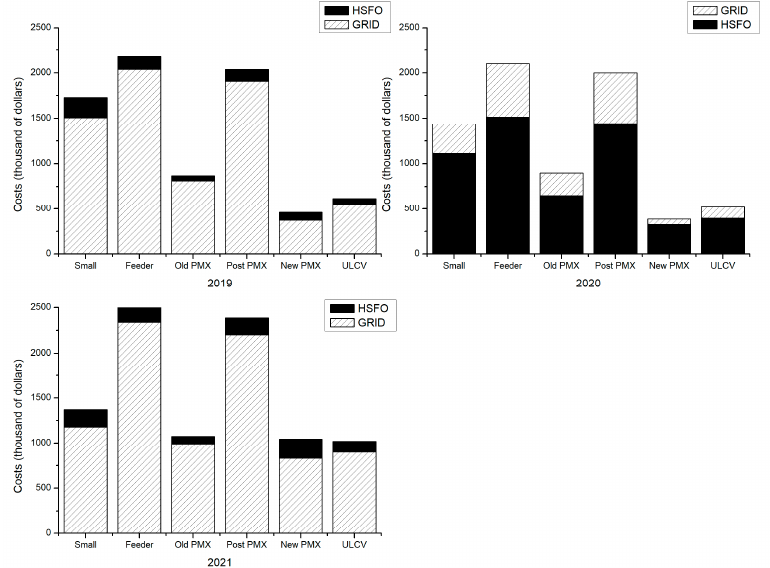
Figure 3. Costs differences in fuel oil and electricity prices (HSFO).